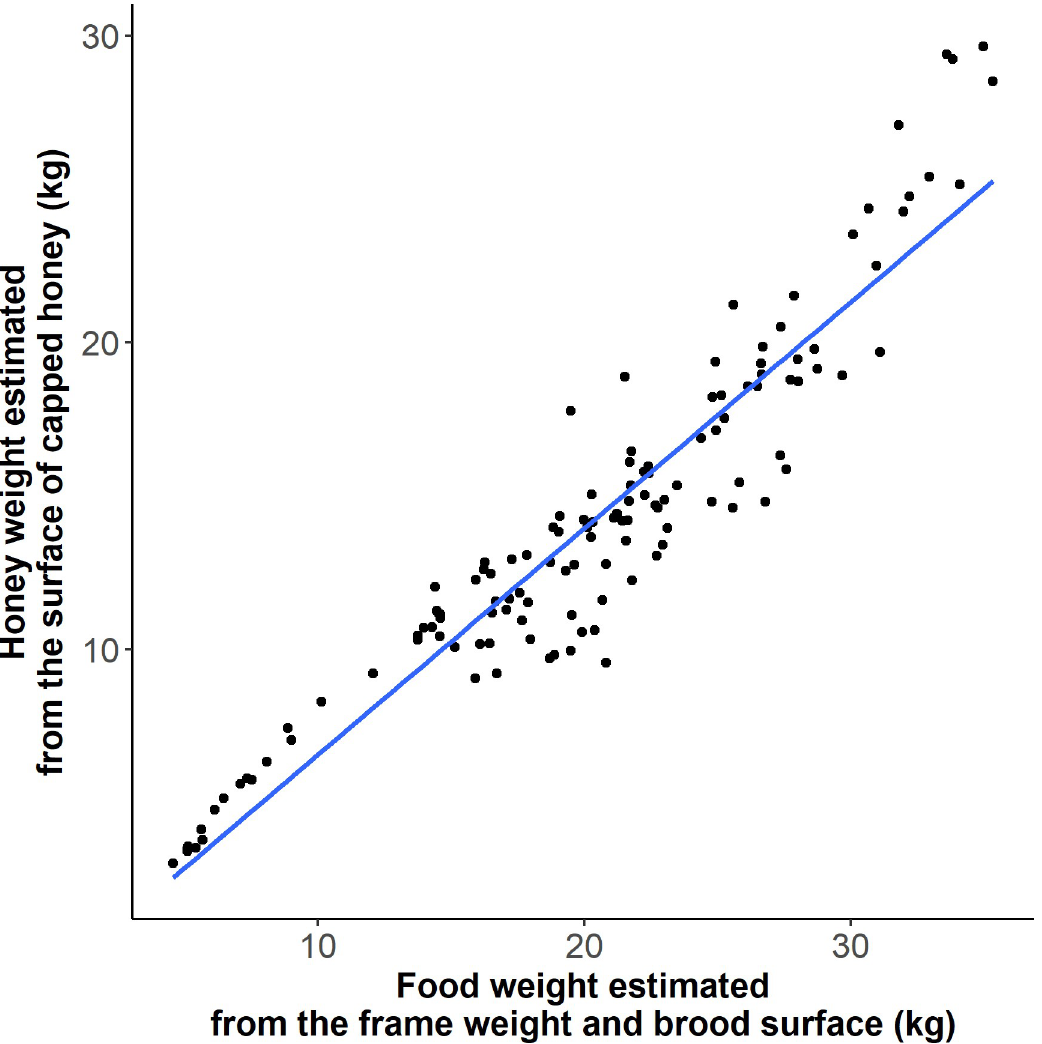
Fig 5. Development of a honey bee colony: Estimation of honey weight from the surface of capped honey and by subtracting the estimated weight of brood, wood, and wax from the weight of each frame measured during hive evaluations.